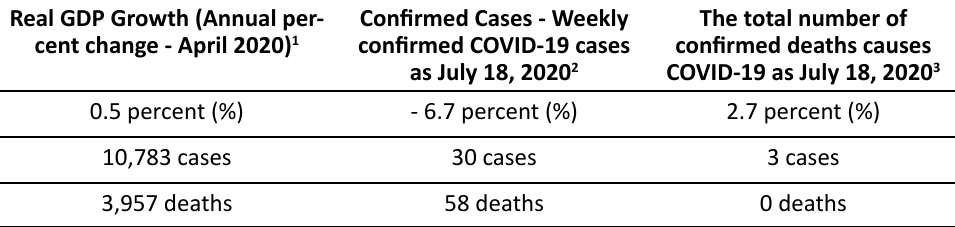
Table 3: GDP Growth and Confirmed Cases During COVID-19 Pandemic Real GDP Growth (Annual per